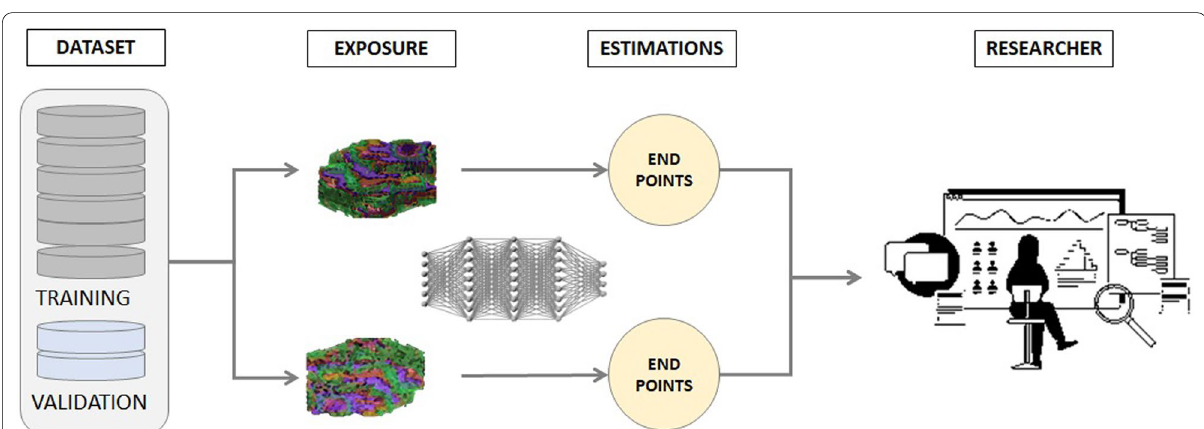
Fig. 3 Flow chart from data recruitment and creation of dataset to data